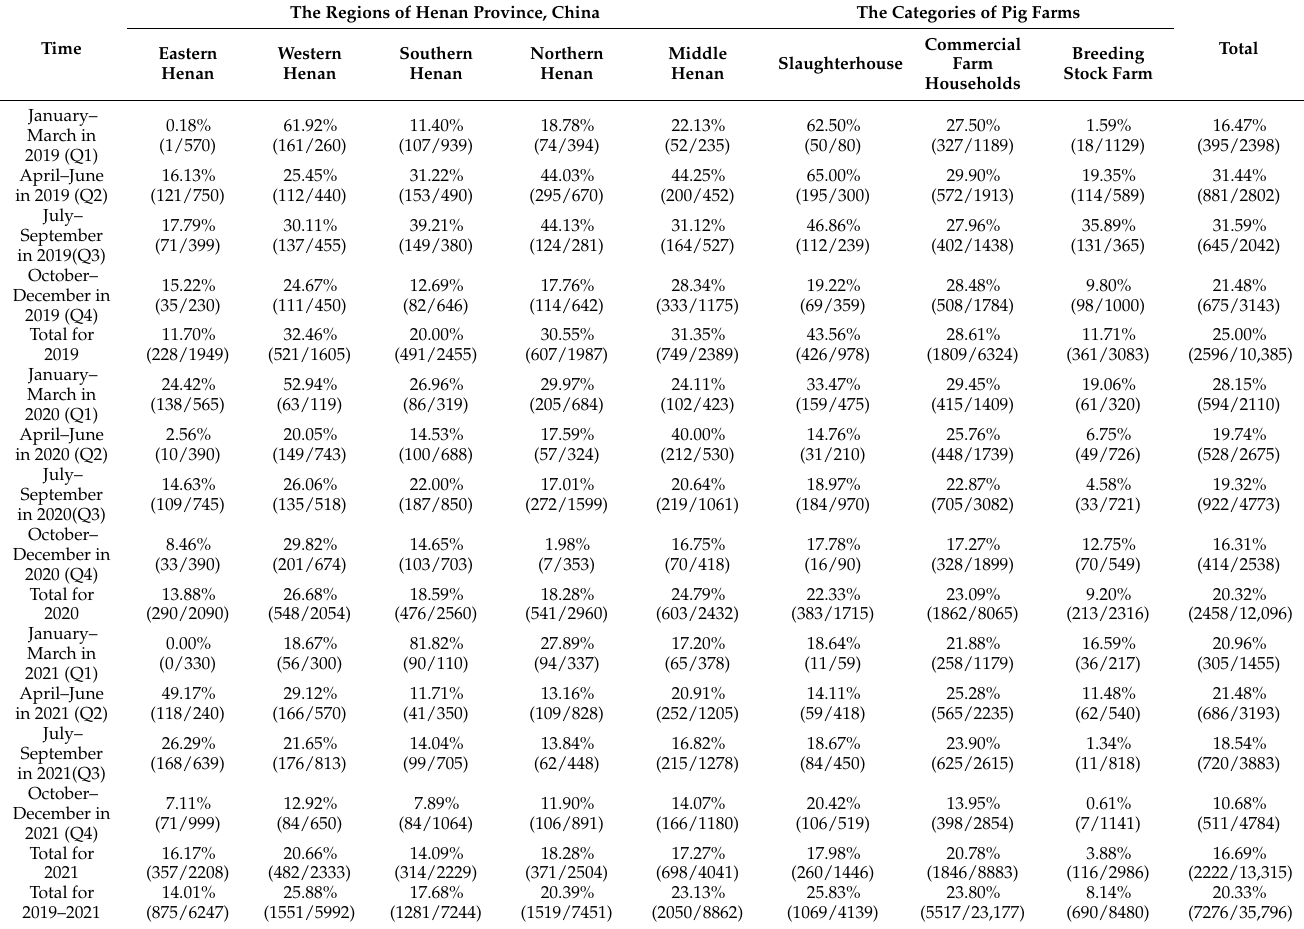
Table 1. The detection results for pseudorabies virus in different regions and different pig farms in the Henan province of China during 2019–2021.